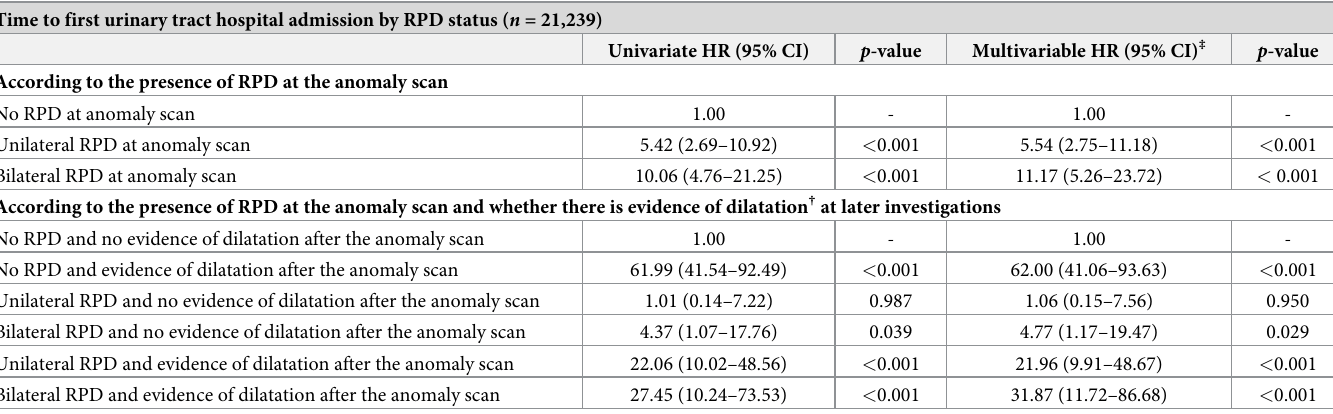
Table 4. HRs for time to first urinary tract hospital admission with unilateral or bilateral RPD. Time to first urinary tract hospital admission by RPD status ( n =